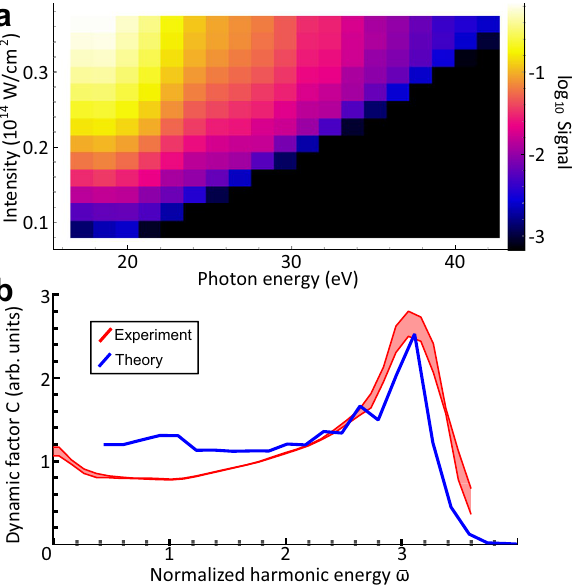
Figure 2. ( a ) An example of a two-dimensional intensity versus HHG spectrum recorded for benzene. Note the linear scaling of the cut-off with intensity in this non-saturated measurement regime. ( b ) Dynamical factor C obtained from fitting to experimental (red) and simulated (blue) HHG intensity scans in xenon. The experimental shaded area for xenon represents the mean plus/minus one standard deviation of the fits obtained by varying the numerical parameter N C (see SI sect.